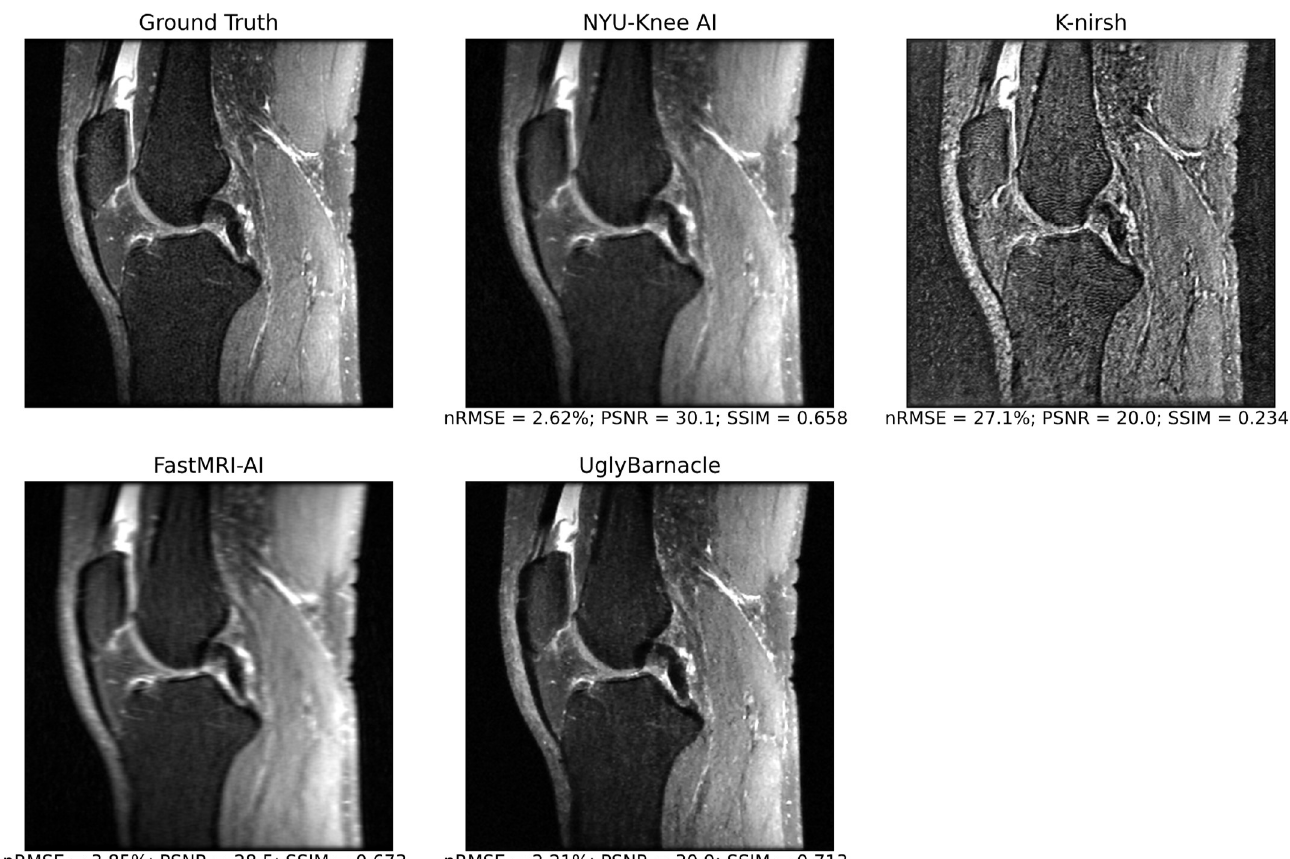
Figure 6. Intermediate pipeline reconstruction outputs for each of the top 4 submissions in an example sagittal slice, as well as ground truth, with reconstruction metrics displayed for the volume including the visualized slice. For this volume, UglyBarnacle delivers the highest quality reconstruction, followed closely by NYU-Knee AI, recovering sharpness and many fine details lost to aliasing during 8× Poisson undersampling. K-nirsh delivers an intermediate reconstruction that was poor by standard reconstruction metrics, but perceptually, made boundaries between tissues much more distinct and perhaps easier to segment. This is likely due to K-nirsh fine-tuning the reconstruction and segmentation networks in an end-to-end manner, unlike other top submissions.